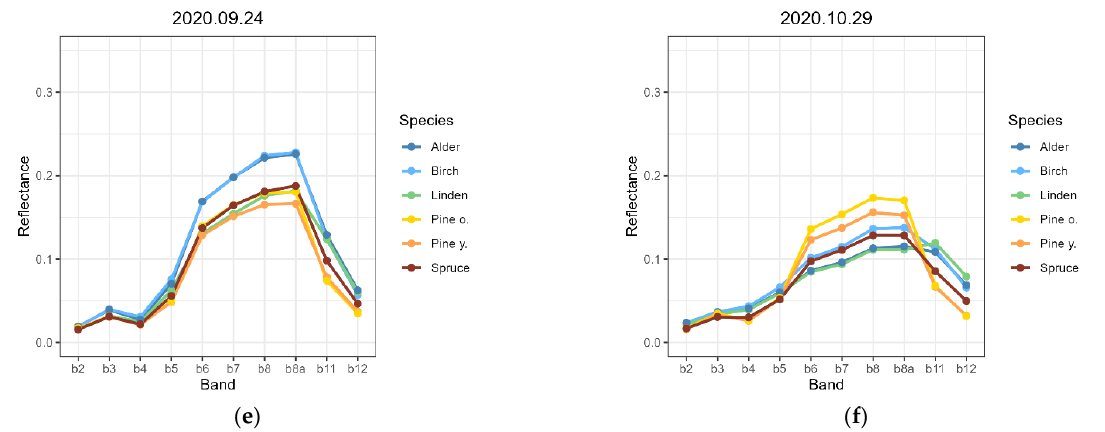
Figure 4. Spectral signatures of tree species for different phenological dates: ( a ) 9 May 2020; ( b ) 21